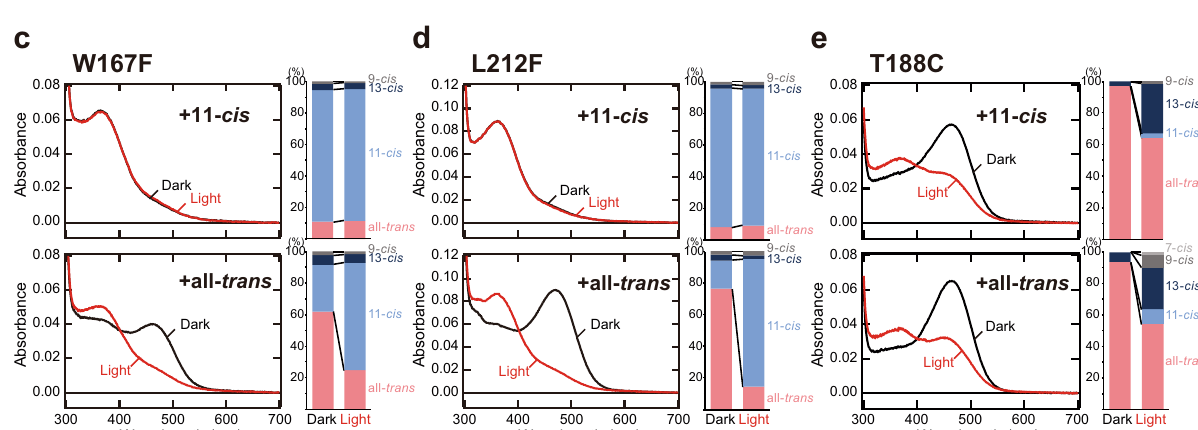
(upper right panel of Fig. 1e and right panel of Supplementary Fig. 2d). The presence of all- trans retinal bound form was con fi rmed by the yellow light-dependent spectral shift to the UV region (red curve of the upper left panel in Fig. 1e and left panel in Supplementary Fig. 2d), which was not observed in wild-type and two other mutant proteins (W167F and L212F). T188C mutant protein puri fi ed after the addition of all- trans retinal also contained predominantly all- trans retinal (94%) (lower right panel of Fig. 1e and right panel of Supplementary Fig. 2h) and showed the absorption spectrum (black curve of the lower left panel in Fig. 1e) quite similar to that of the sample prepared after the addition of 11- cis retinal. Yellow light irradiation of this sample induced the trans - cis isomerization of the retinal (lower right panel of Fig. 1e) and shifted the absorption spectra into the UV region (red curve of the lower left panel in Fig. 1e and left panel in Supplementary